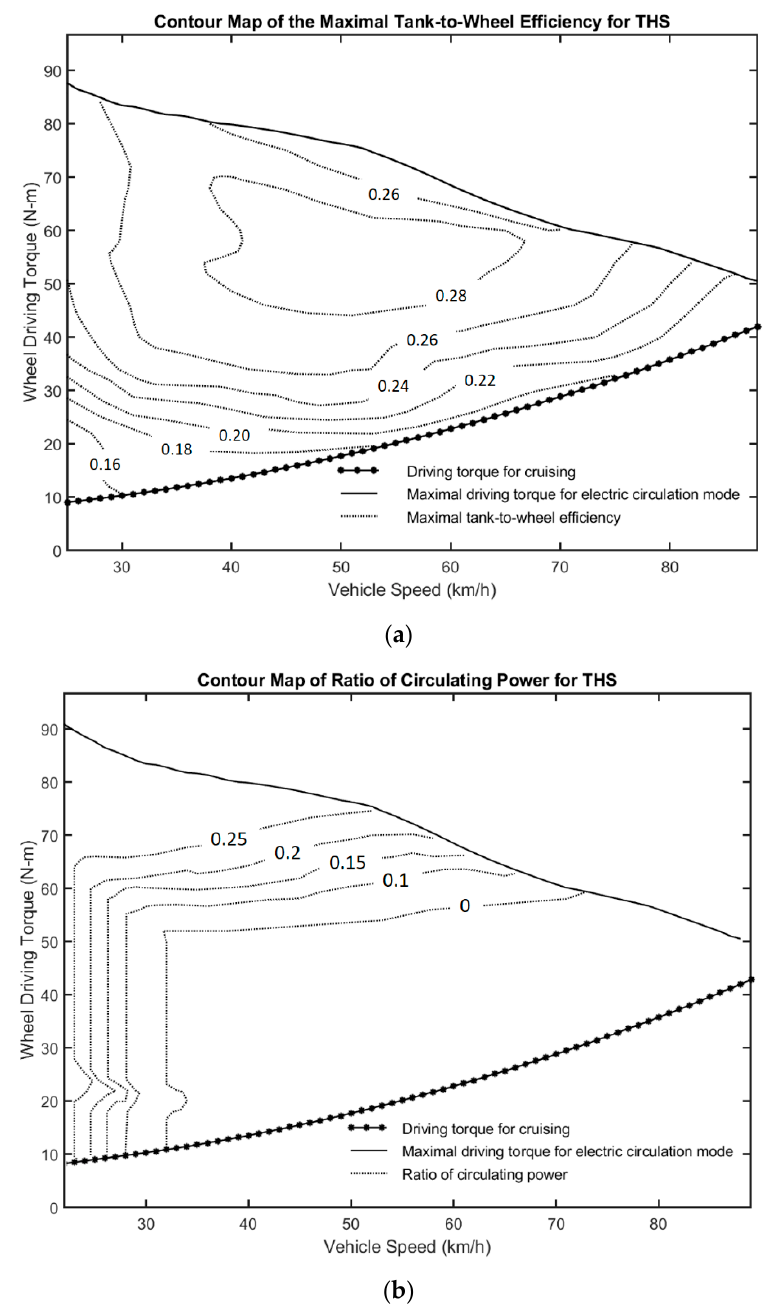
Figure 10. Contour maps of ( a ) maximal η tw and ( b ) ζ vs. vehicle speed and wheel driving torque for THS